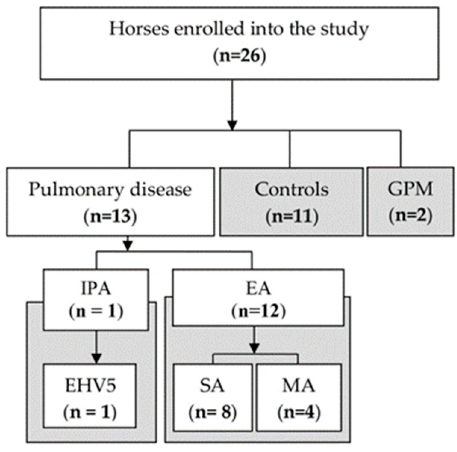
Figure 1. Flowchart of the study. IPA—Invasive Pulmonary Aspergillosis; GPM—Guttural Pouch Mycosis; EHV5—Equine Herpes Virus 5; EA—Equine Asthma; SA—Severe Asthma; MA—Moderate Asthma .